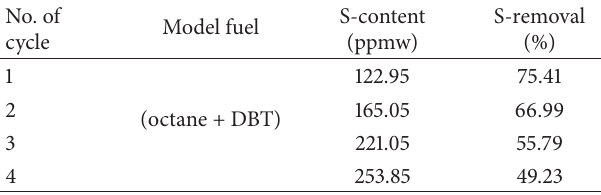
Table 2: Recycling of spent [BMIM]Cl without